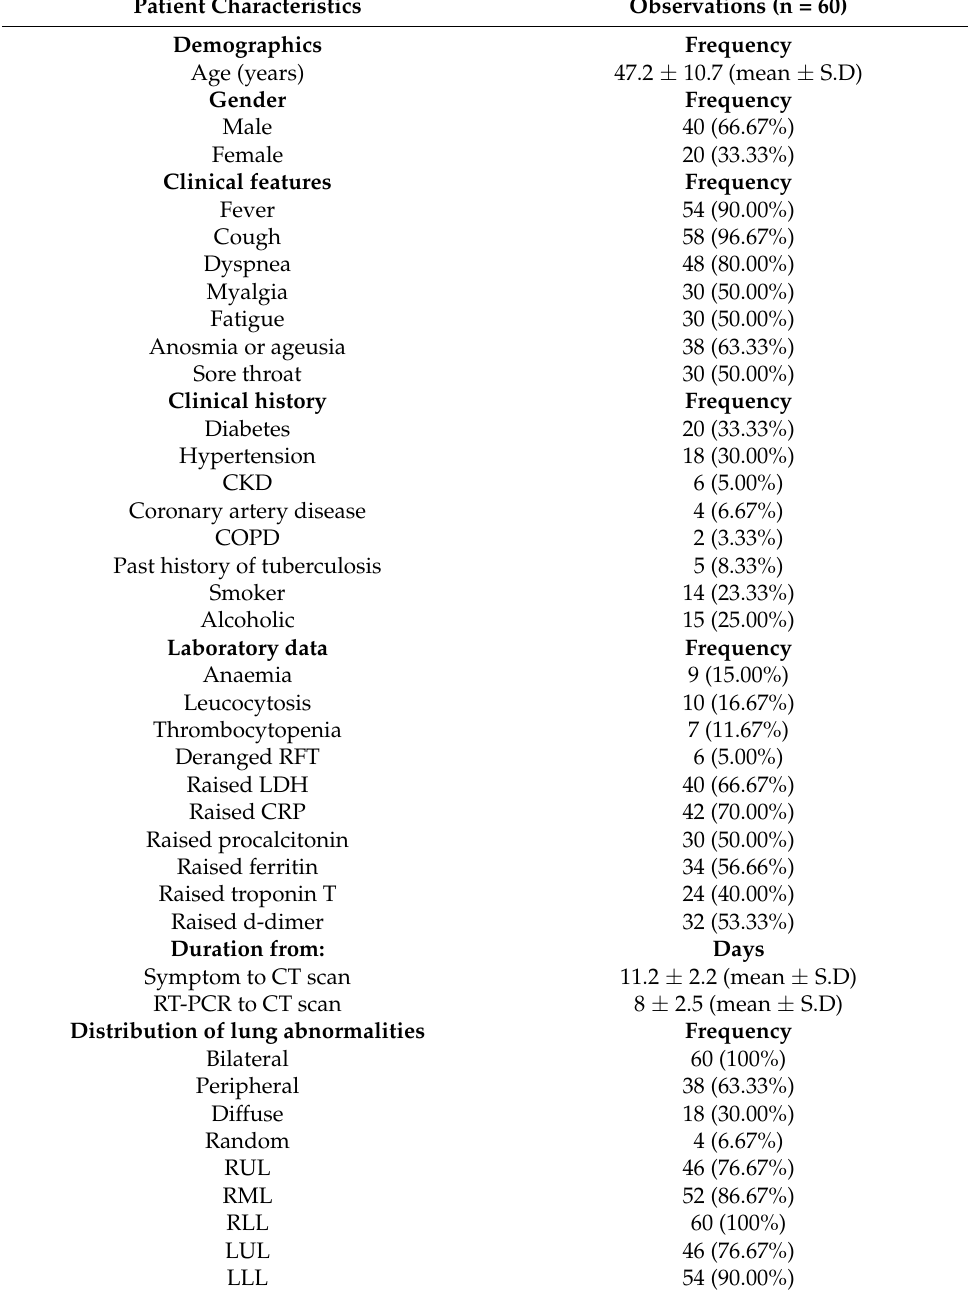
Table 2. Demographic, clinical, laboratory details and distribution of lung involvement on chest CT of the study